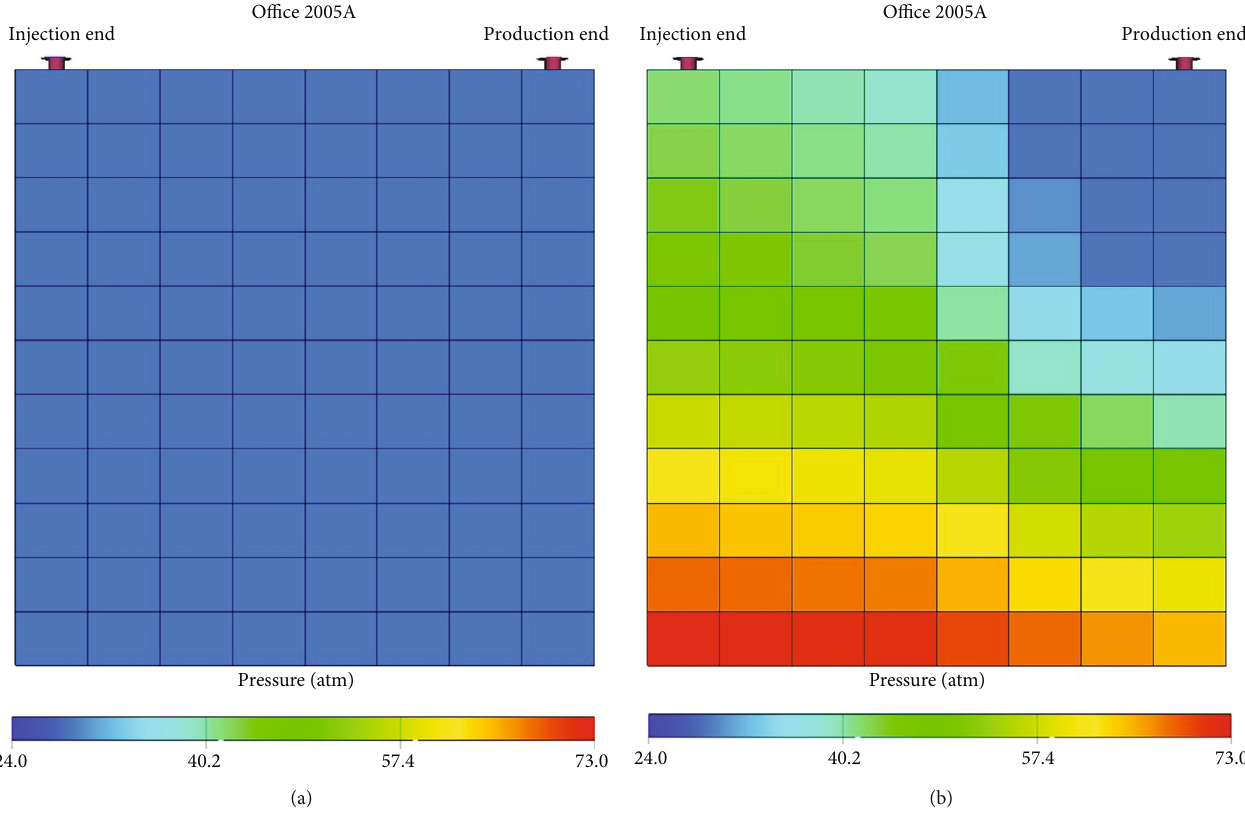
Figure 8: (a) Initial pressure pro fi le; (b) pressure pro fi le after